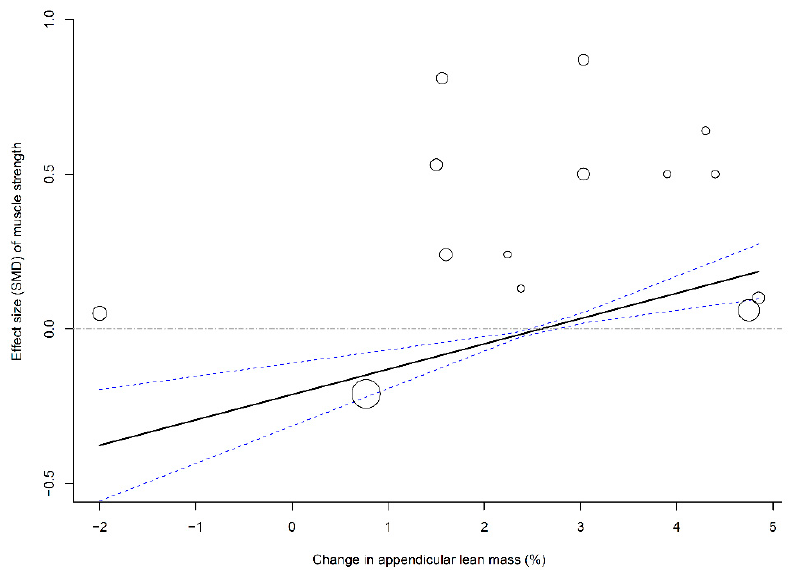
Figure 4. Multivariate meta-regression between percentage change in appendicular lean mass and effects of PS plus MSE on leg strength. Each circle represents an independent comparison. The size of each circle is proportional to that study’s weight (inverse variance weighted). The regression prediction is represented by the solid line for effect size (SMD) of leg strength. Dotted lines represent the 95% CI. The metaregression model was adjusted for age, methodological quality, and follow-up time of each comparison. PS, protein supplementation; MSE, muscle strengthening exercise; SMD, standard mean difference.